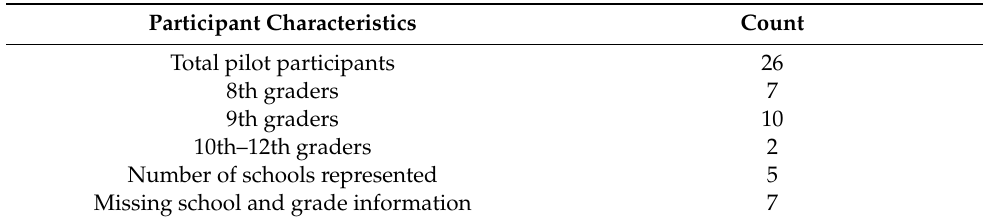
Table 1. Pilot participant